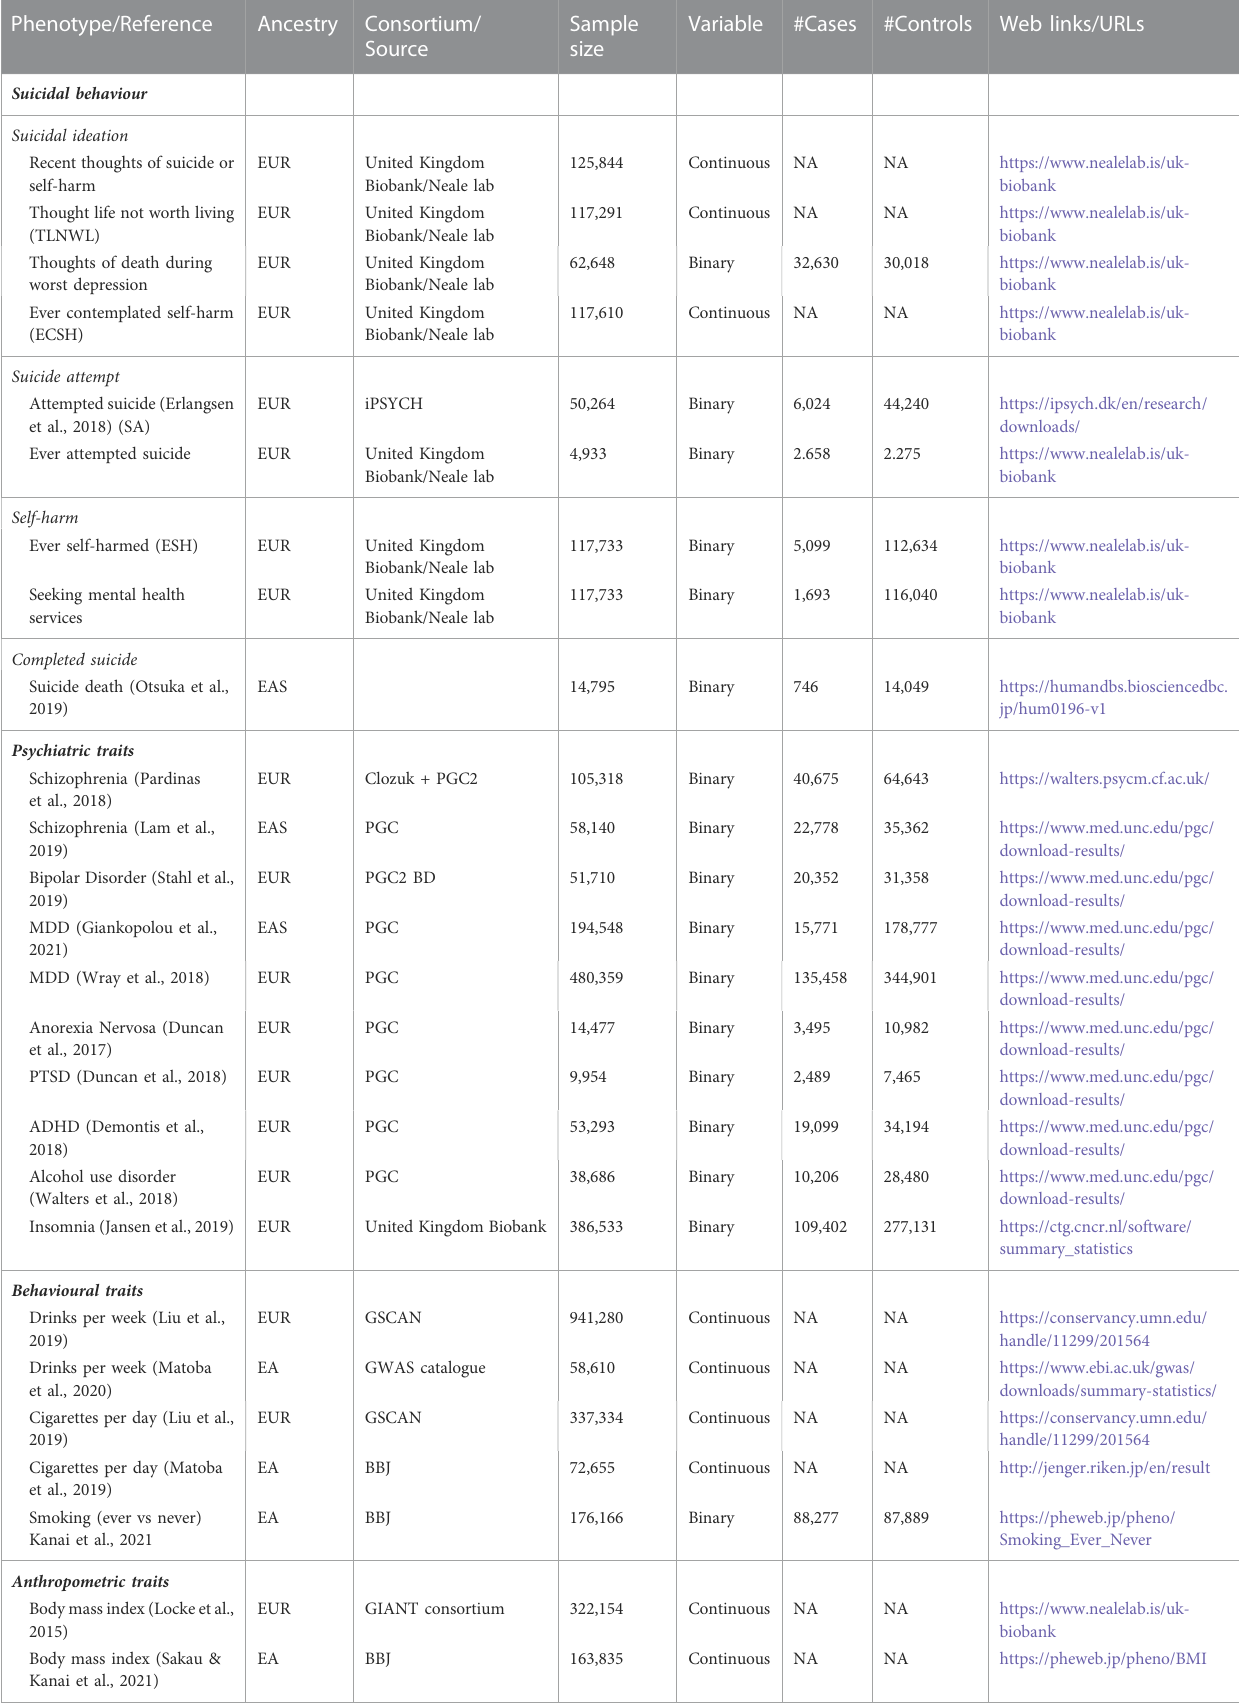
TABLE 1 Data sources and description of suicidal behaviour, psychiatric, behavioural and socioeconomic GWAS